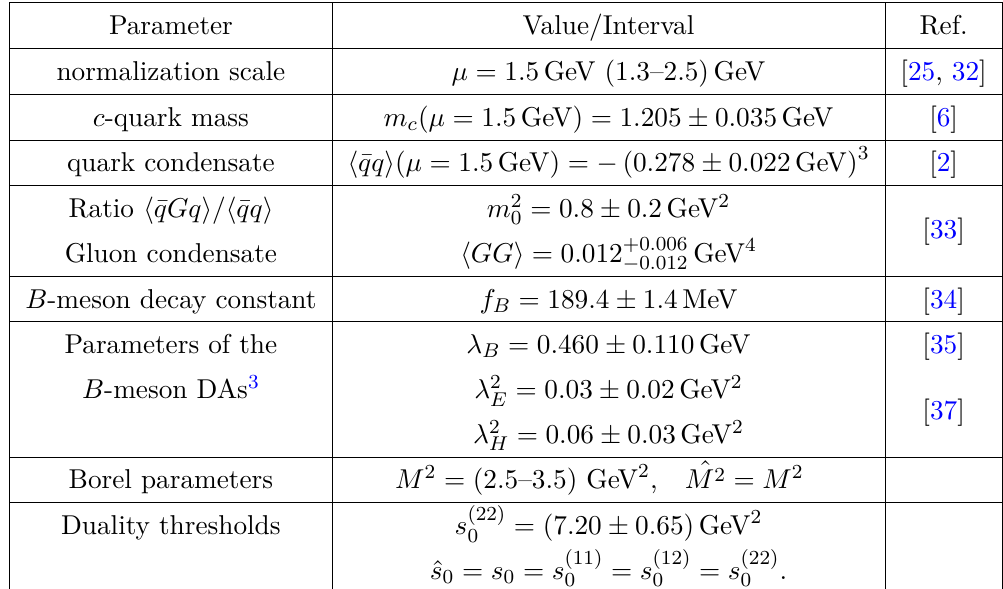
Table 2 . Input values used in the numerical analysis of the two-point sum rules and the LCSRs.